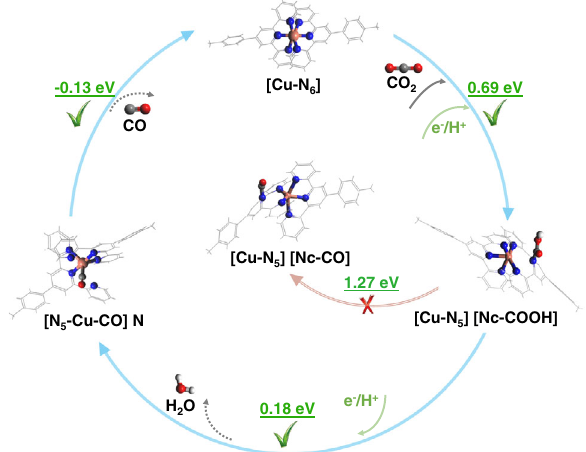
Fig. 4 | A baton-relay-like mechanism of actives sites transfer for the electro- catalytic CO2RR to CO on Cu(Tpy)2-KB@GC catalyst. H atoms are in white, C atomsingray,Natomsinblue,OatomsinredandCuatomsinbrown,respectively. Free energy change ( Δ G ) values for key bifurcating intermediates are annotated in